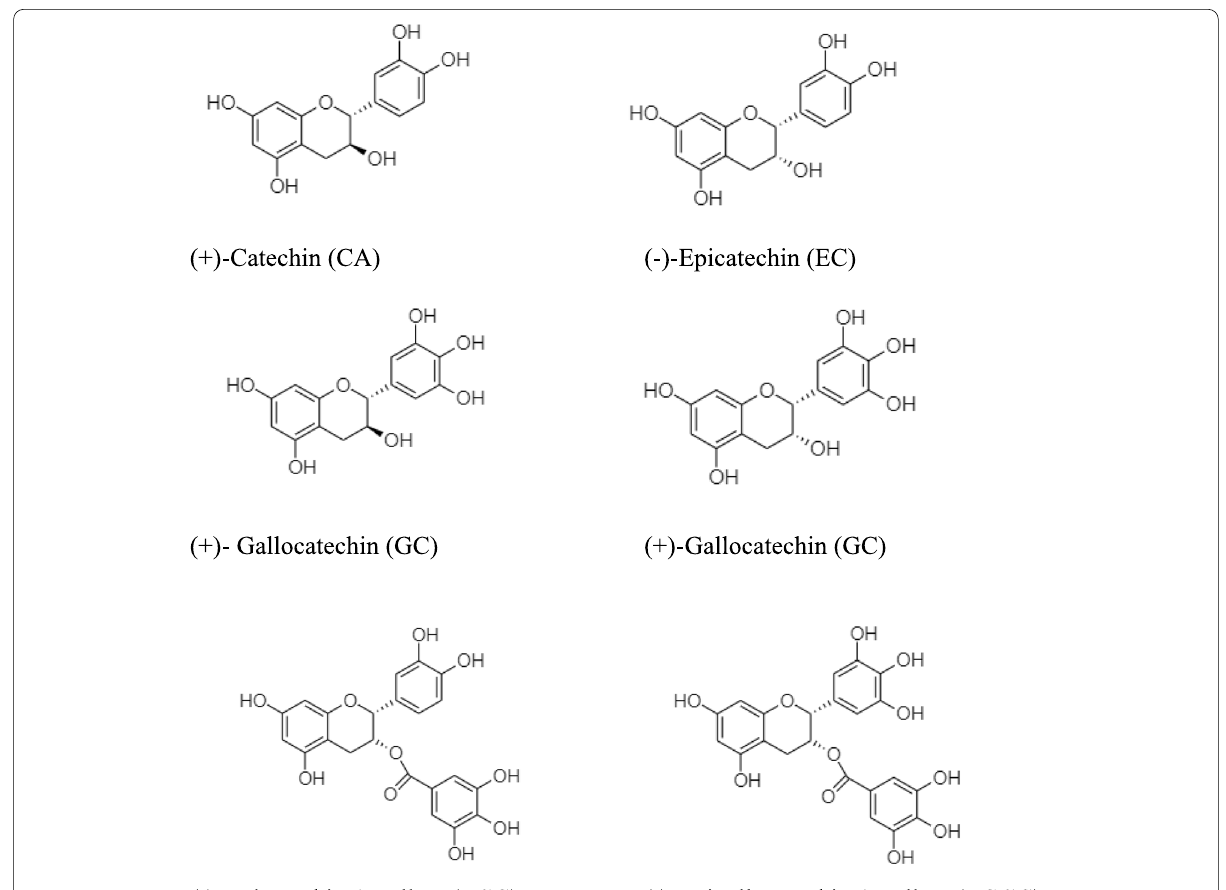
Fig. 5 Chemical structures of